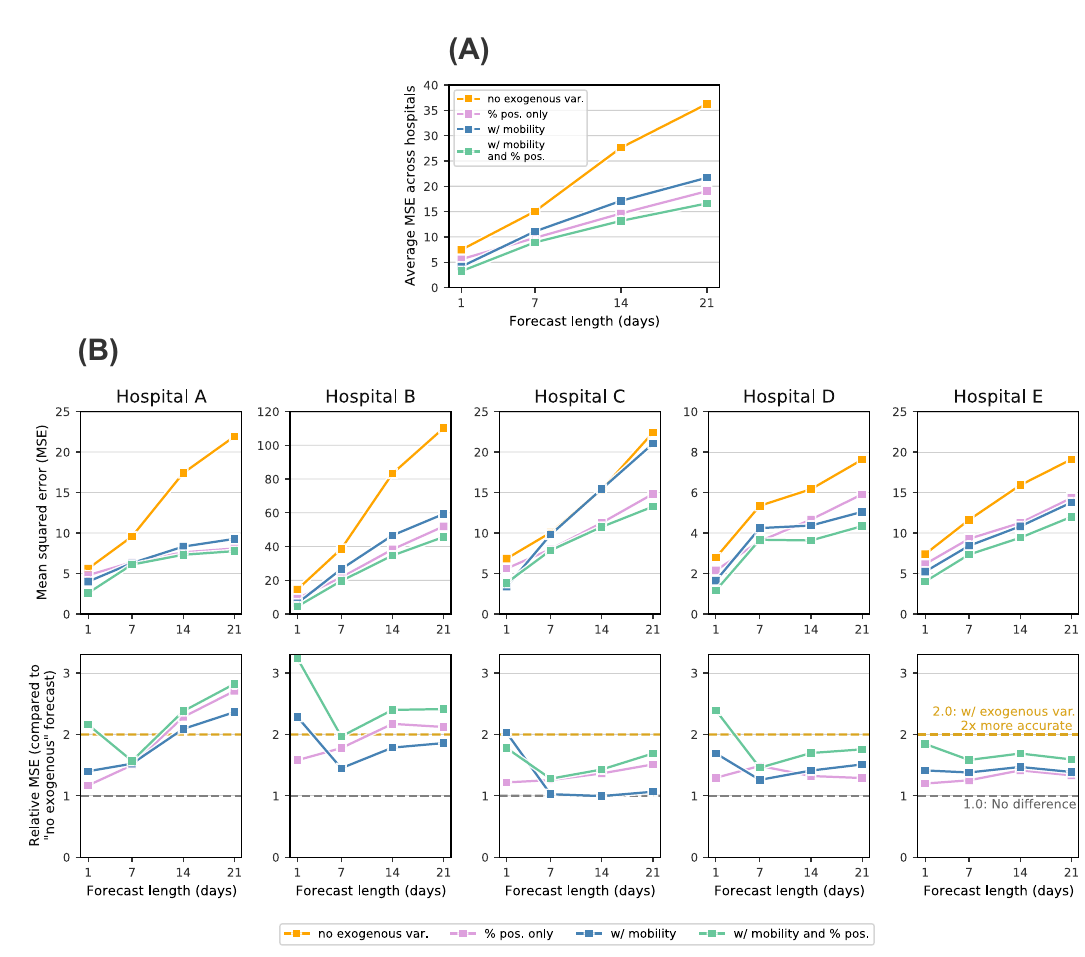
Fig. 3 Comparison of forecasts with/without mobility data. A Average mean squared error (MSE) across all fi ve hospitals under forecasts that (1) do not include exogenous data (orange), (2) include test positivity data from across Massachusetts (pink), (3) include mobility data (blue), and (4) include both mobility and test positivity data (green). B Top: Hospital-speci fi c MSE, separated by forecast method. Bottom: relative performance, using the forecasts that do not include exogenous variables as a